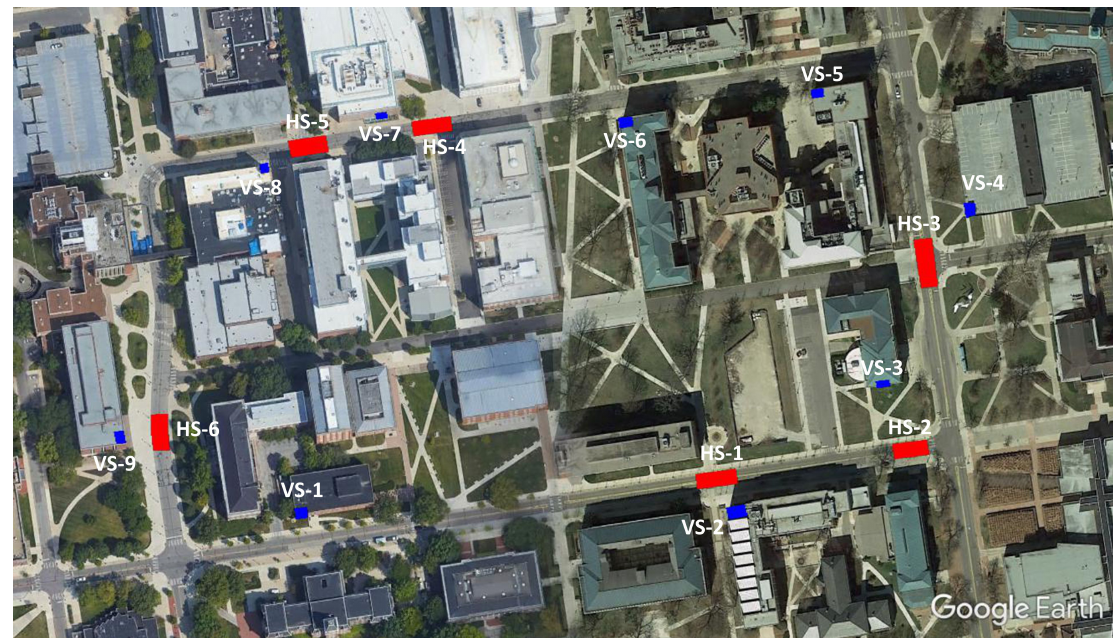
Figure 10. Checkpoints and reference surface locations at the OSU main campus (HS: horizontal surfaces, VS: vertical